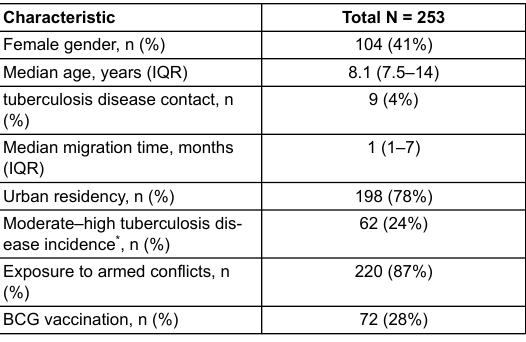
Table 1: Baseline characteristics of the population.